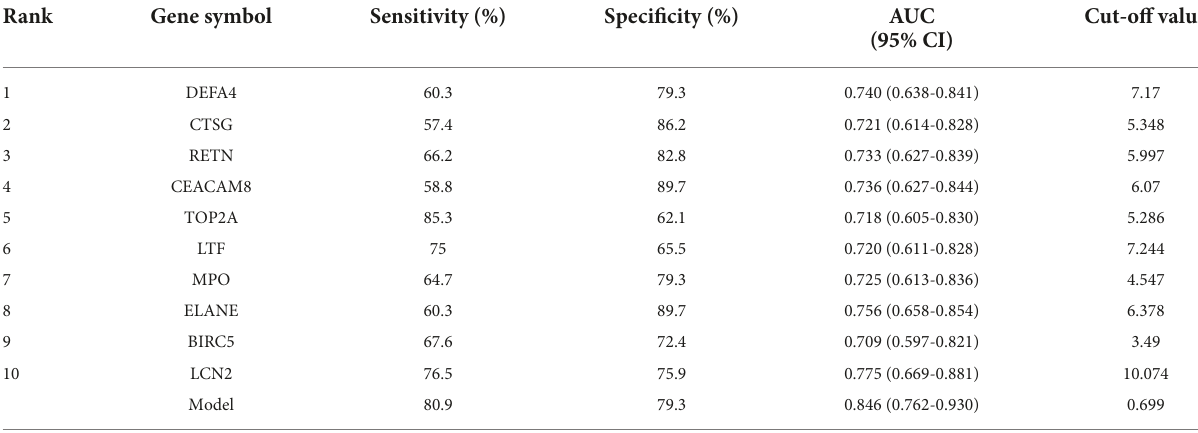
TABLE 6 The sensitivity, specificity, and AUC of the identified hub genes in detecting renal involvement patients with SLEDAI > 15.